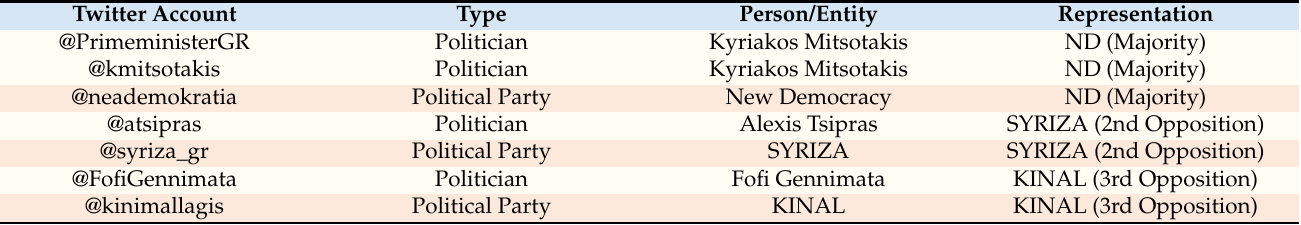
Table 3. Sentiment values used for the labelling process by the sentiment analyzer.